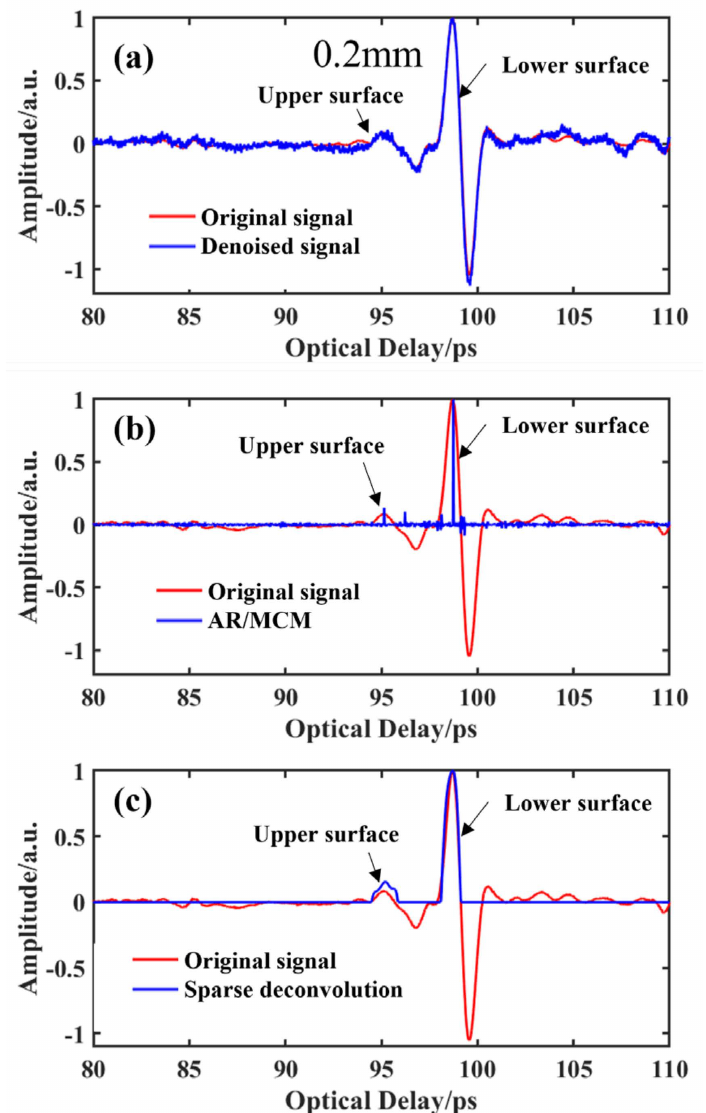
Figure 8. The results obtained by the different methods for the sample when the thickness of glue is